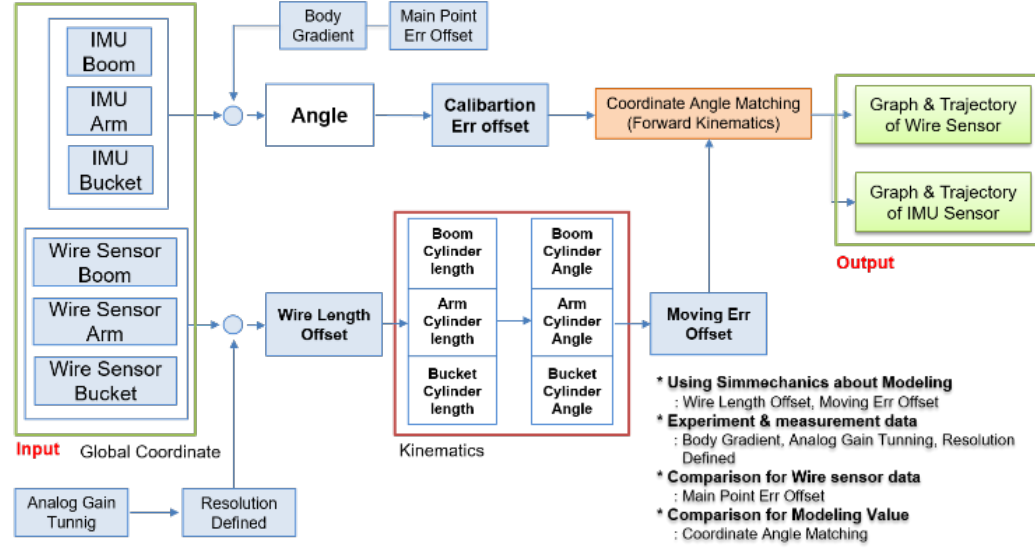
Figure 13. Flow chart of the phases of data collection from both sensors through the compensation